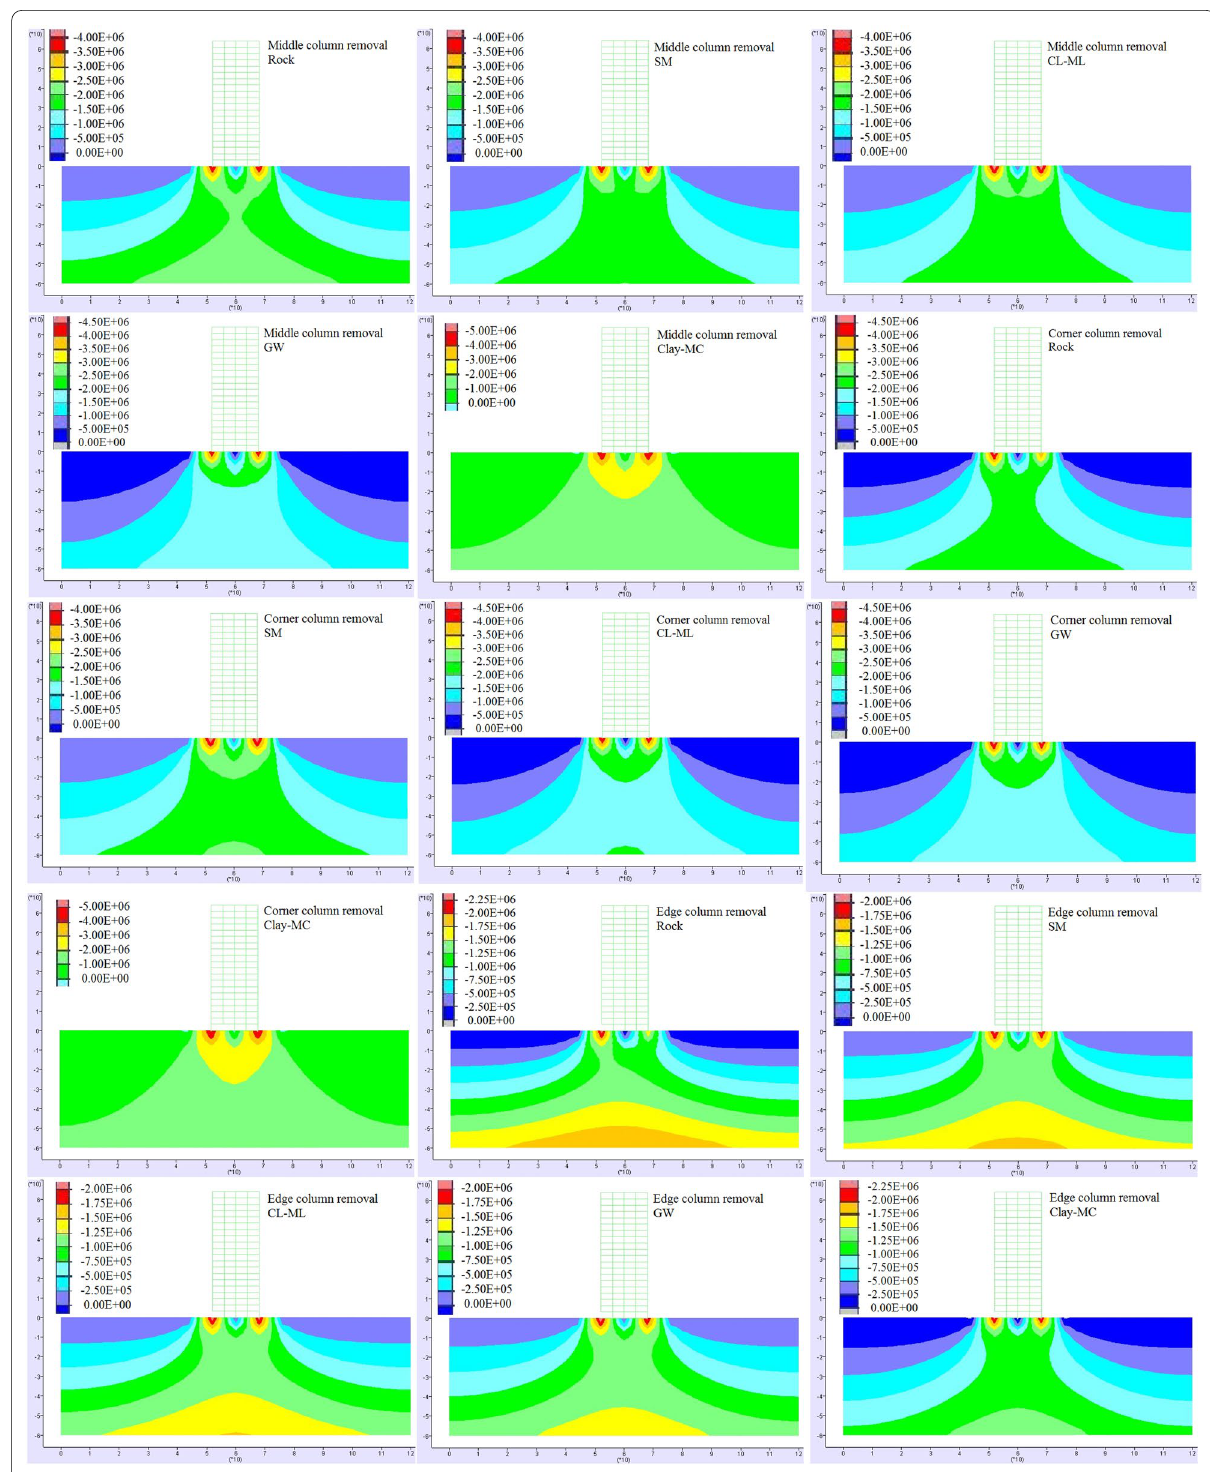
Fig. 13 SYY contours of the frames with column removal with different soil